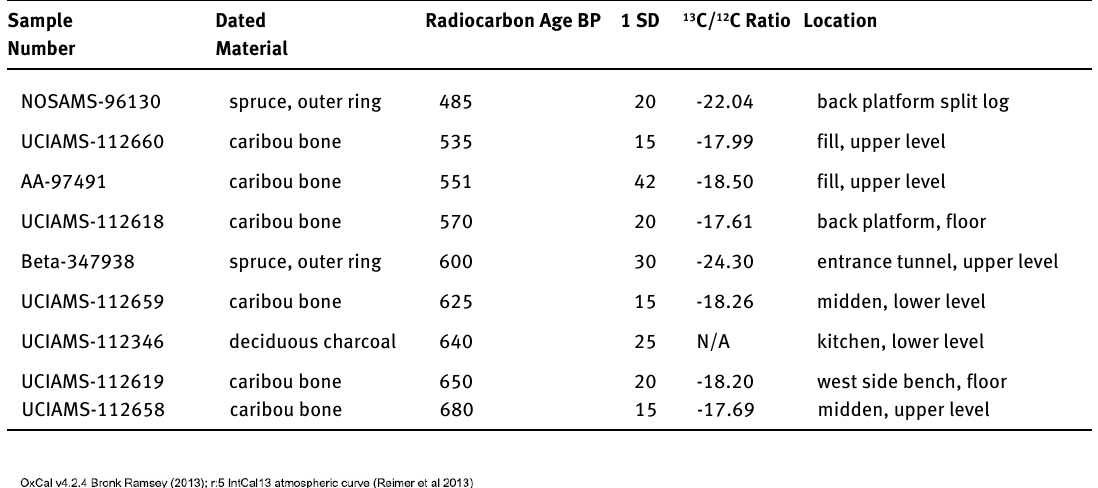
Table 1: Radiocarbon dates for Feature 87.